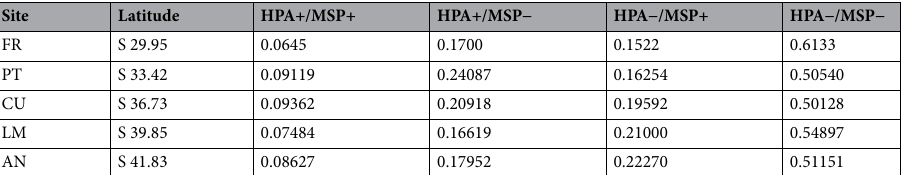
Table 2. Overall methylation levels for the five populations. HPA+/MSP+, unmethylated; HPA+/ MSP−, hemimethylated; HPA−/MSP+, internal cytosine methylation; HPA−/MSP−, uninformative sites; FR, El Frances; PT, Punta Tralca; CU, Los Cuervos; LM, Los Molinos; AN, Ancud.